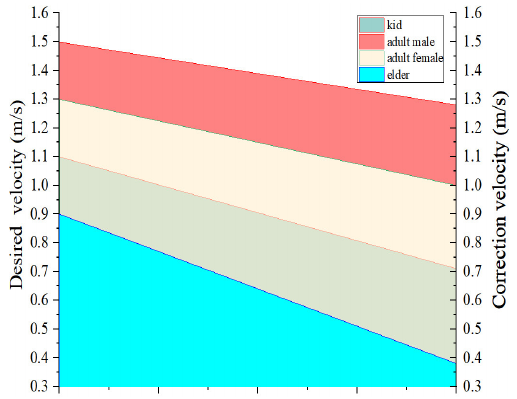
Figure 4. Speed comparison chart.